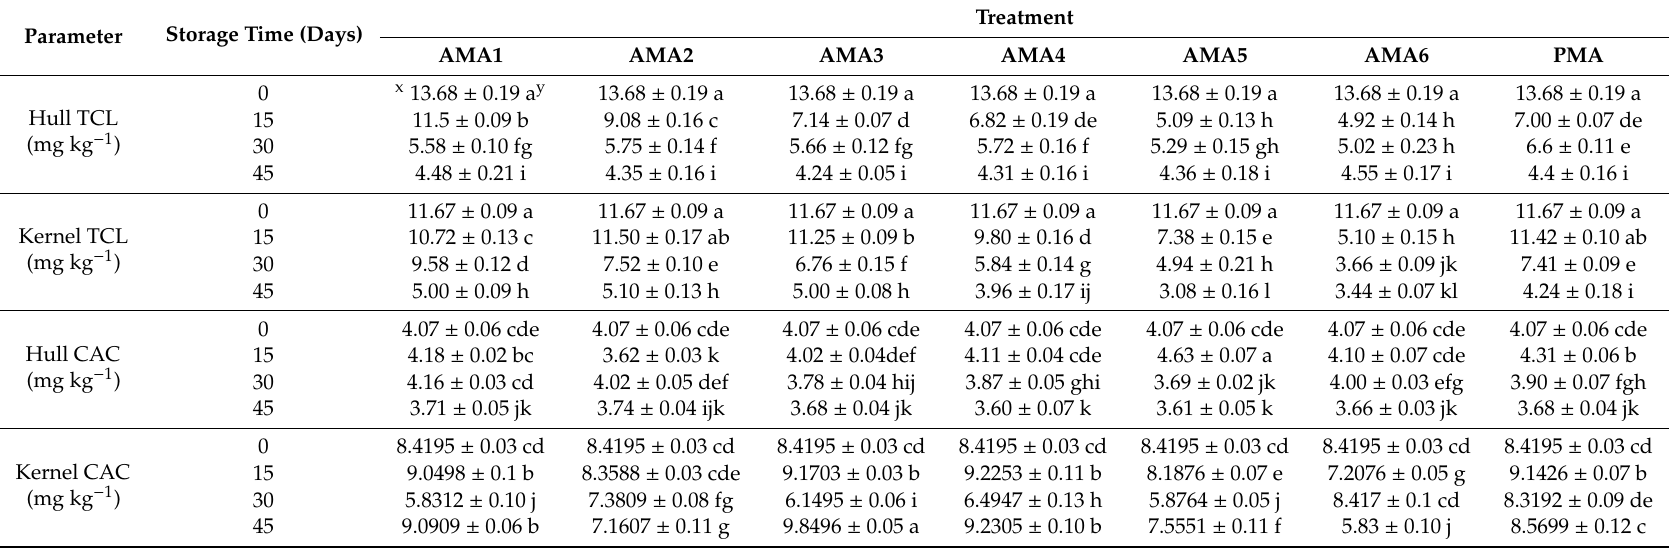
Table 3. E ff ect of di ff erent active-MAP (AMA) and passive-MAP (PMA) conditions on the hull’s total chlorophylls (Hull TCL), kernel’s total chlorophylls (Kernel TCL), hull’s total carotenoids (Hull CAC), and kernel’s total carotenoids (Kernel CAC) of fresh in-hull pistachios stored for 45 days at 4 ± 1 ◦ C and 90 ± 5%